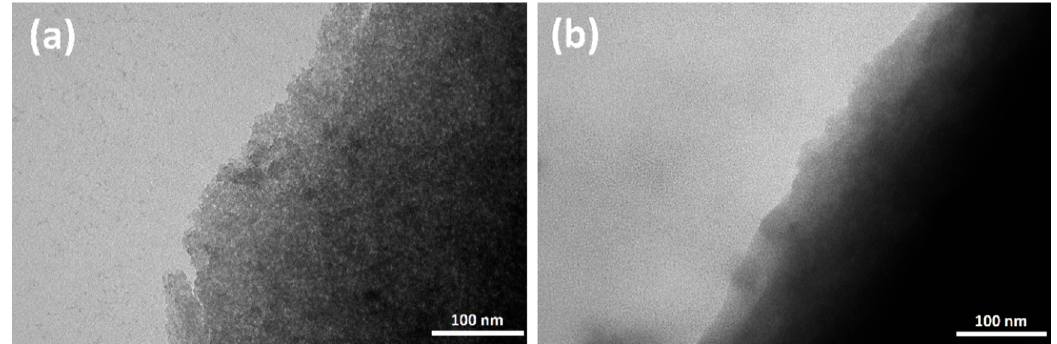
Figure 1. TEM images of SiEu 0.2 before ( a ) and after ( b ) thermal treatment at 900 ◦ C. Cl